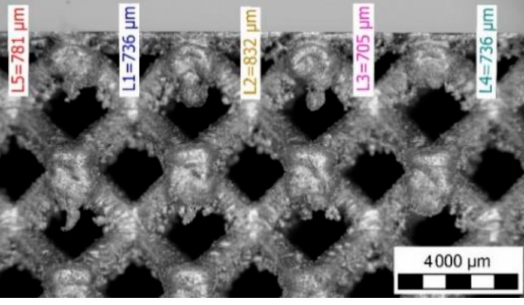
Figure 9. Side view on the C-series specimen using the lighting